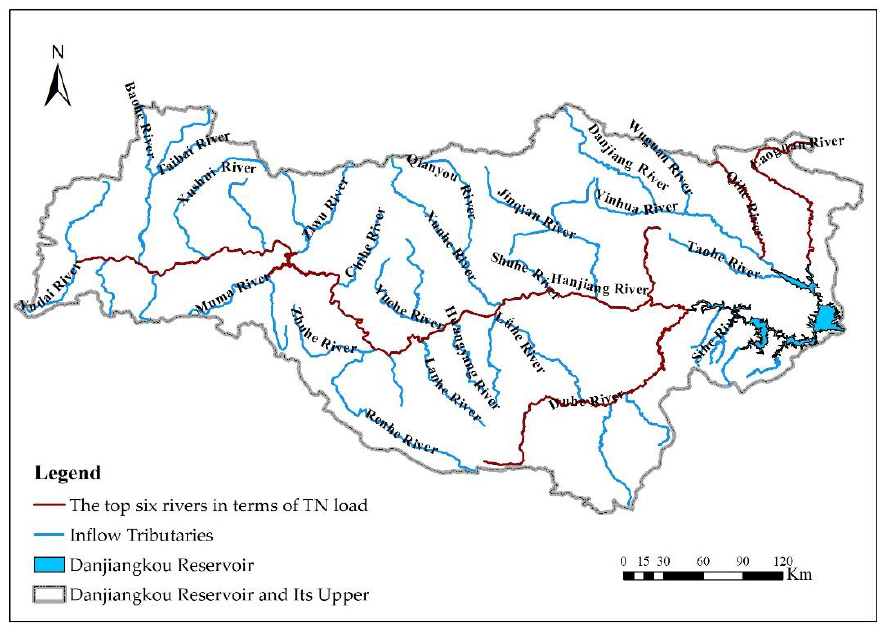
Figure 7. The top six rivers in terms of TN load of the reservoir tributaries.